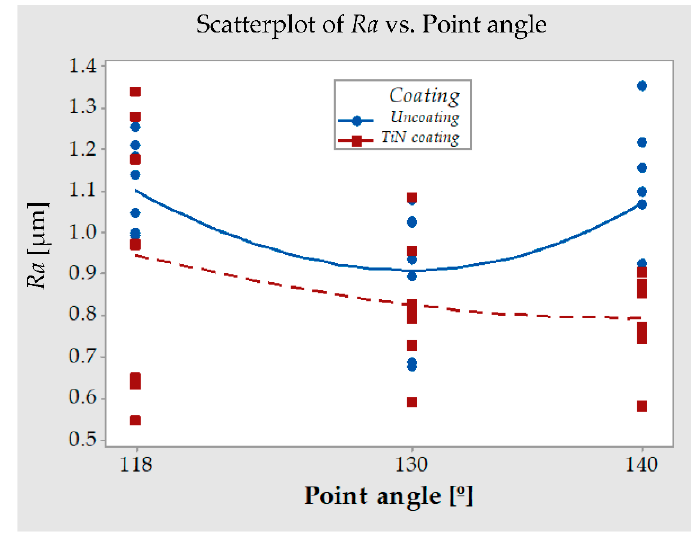
Figure 7. Scatterplot of Ra vs. point angle for both types of drill coating.